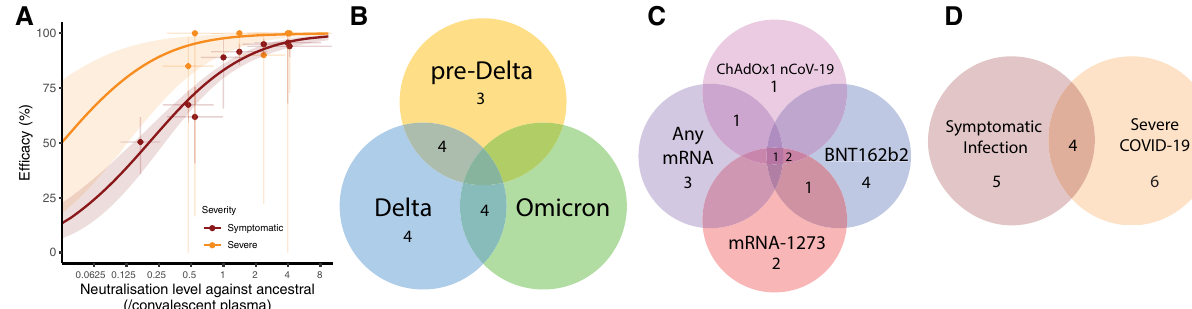
Fig. 1 | Summary of previously available data linking neutralising antibodies and vaccine effectiveness and data contributing to this analysis. A Previously reported relationship between neutralising antibody titre and vaccine ef fi cacy in the prevention of symptomatic (dark red) and severe (orange) COVID-19